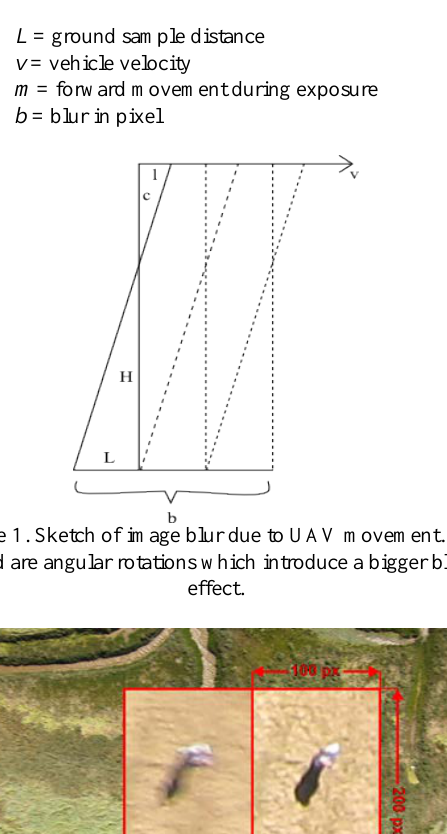
1/100s generates blur equal to 4 pixel.